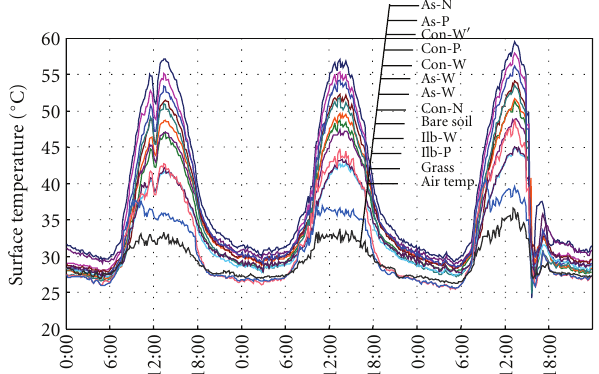
Figure 5: Observed values of surface temperature for each pave- ment surface on August 3 to 5,